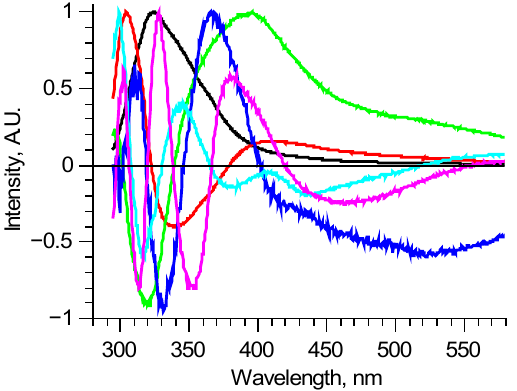
Figure 2. Principal components of all measured laser-induced fluorescence spectra (shown in Figure 1. as an example). Each principal component is an abstract function, and doesn’t directly correspond to real fluorophore.